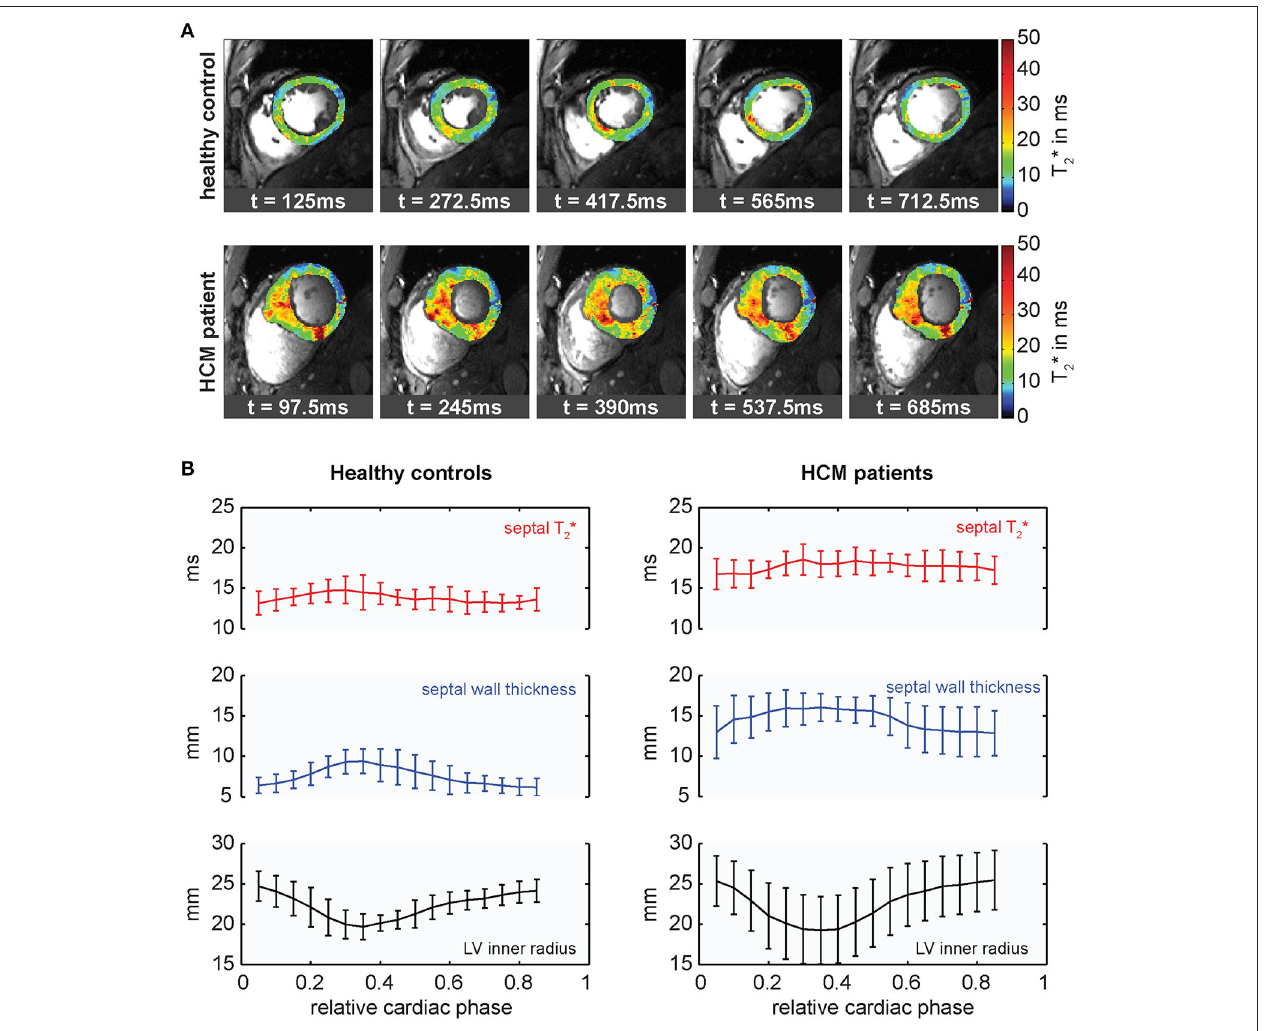
FIGURE 13 | Cardiac phase resolved myocardial T 2 * mapping in healthy volunteers and HCM patients. (A) Temporally resolved myocardial T 2 * maps of a short axis view of a healthy control (top) and an HCM patient (bottom), (5 out of 20 phases shown). Spatial resolution (1.1 × 1.1 × 4.0) mm 3 . T 2 * variations can be observed across the cardiac cycle. (B) Course of mean septal T 2 * , wall thickness and inner LV radius plotted over the cardiac cycle averaged for groups of healthy controls (left) and HCM patients (right). Relative cardiac phase 0 indicates the beginning of systole. T 2 * changes periodically over the cardiac cycle increasing in systole and decreasing in diastole in both, healthy controls and HCM patients, but is significantly elevated in HCM